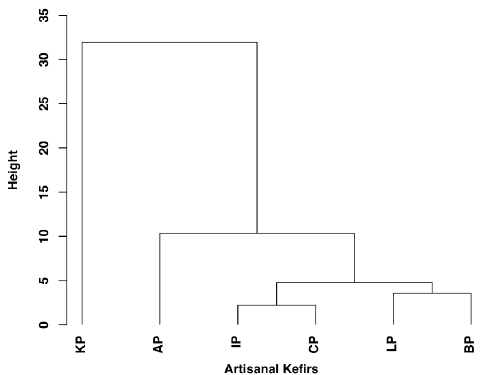
Figure 5. The hierarchical clustering (HC) based dendrogram showing species level taxonomy relatedness for all kefir products (X-axis) from Lithuania (LP) and South Korea (KP), Ireland (IP), the Caucuses region (CP), Britain (BP), and Fusion Tea (AP, Amazon). The complete linkage method used for computing distance between clusters to determine similar clusters.